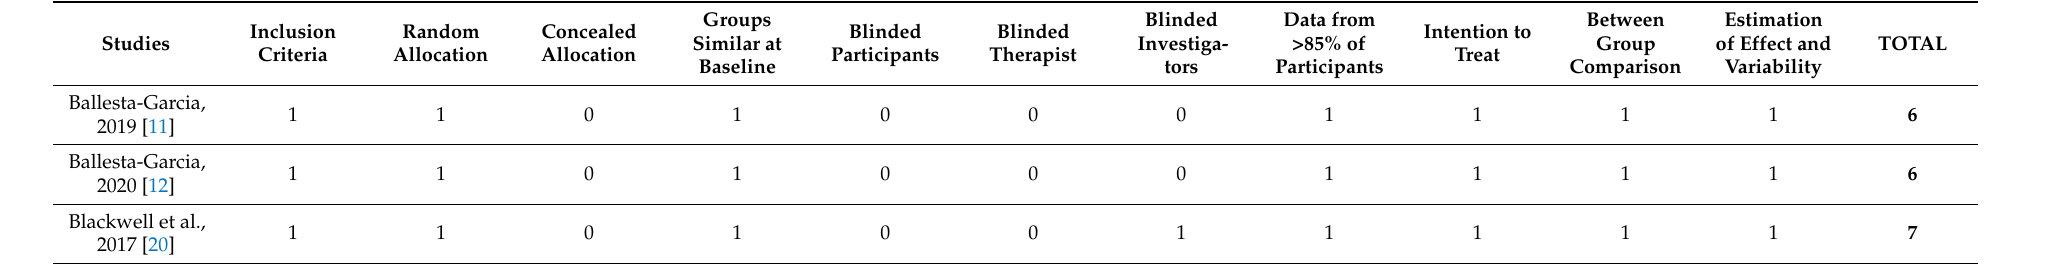
Table 3. Methodological quality assessment (PEDro